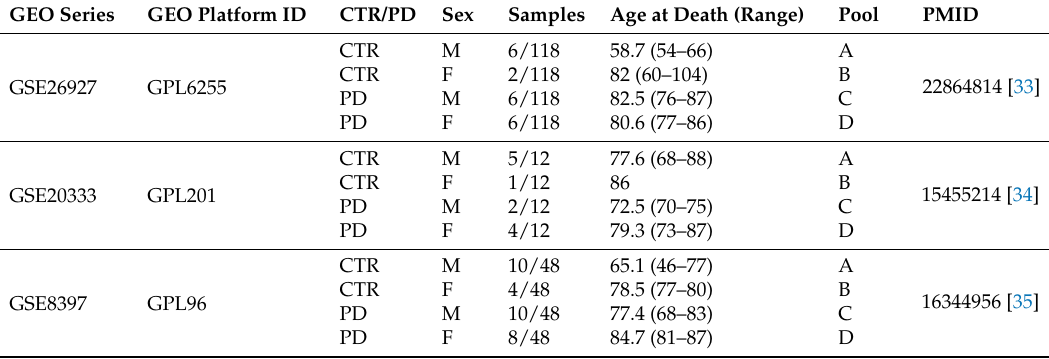
Table 1. Main features of the samples selected for the meta-analysis with Transcriptome Mapper (TRAM)